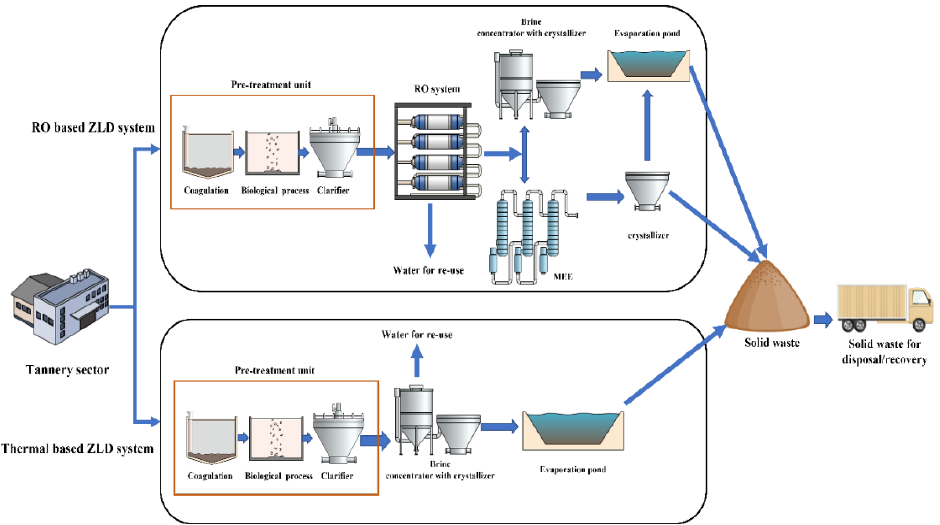
Figure 3. Schematic illustration of thermal- and RO-based ZLD systems